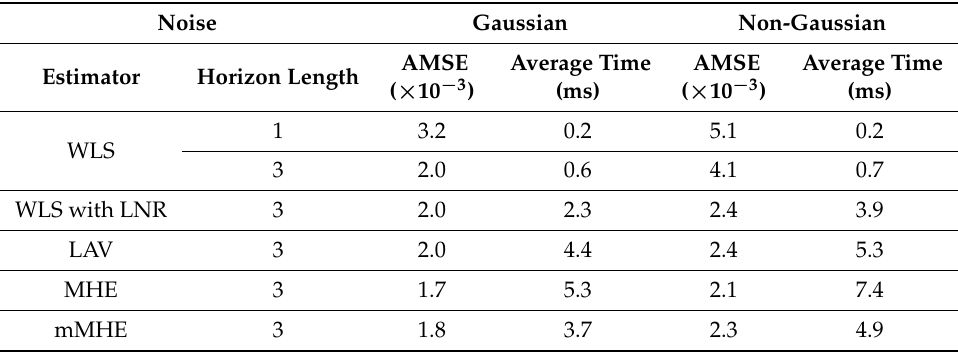
Figure 9. The Mean Square Error (MSE) of different estimators. “WLS(1)” represents the results when the WLS estimator uses the measurements with horizon length 1. ( a ) under Gaussian assumption. ( b ) under non-Gaussian assumption. Table 3. The AMSE and average computation time (per step) with different estimators in the IEEE 14-bus system installed with minimum number of